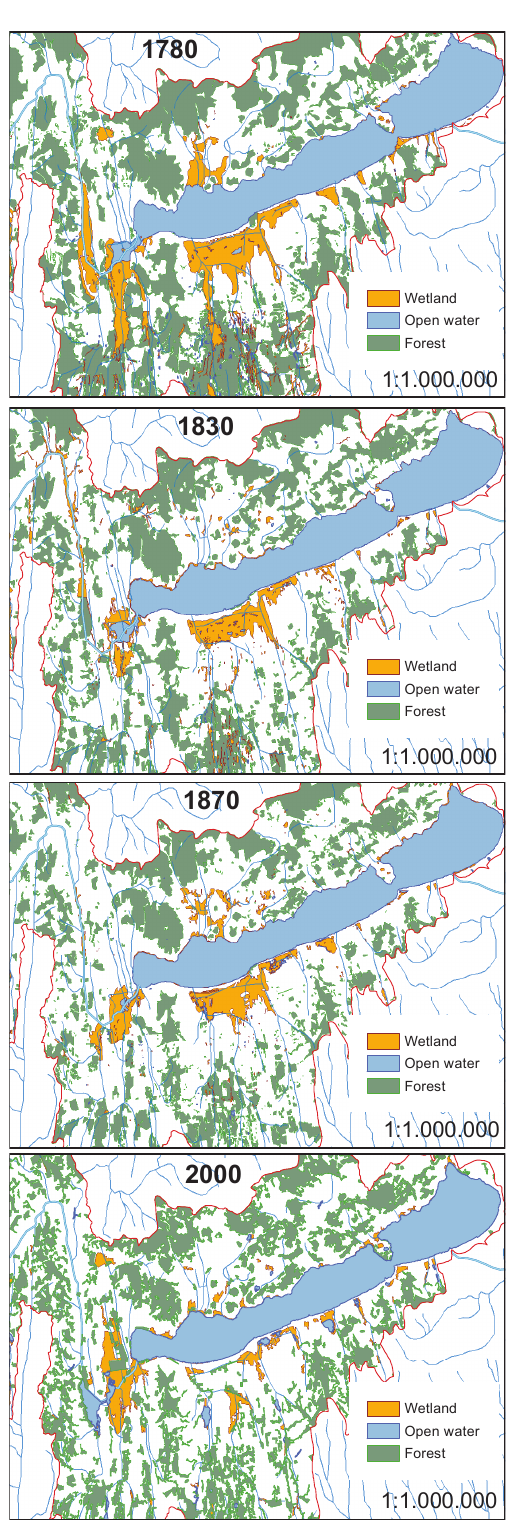
Fig. 5. Historic extents of wetlands, forests and open water on the Lake Balaton